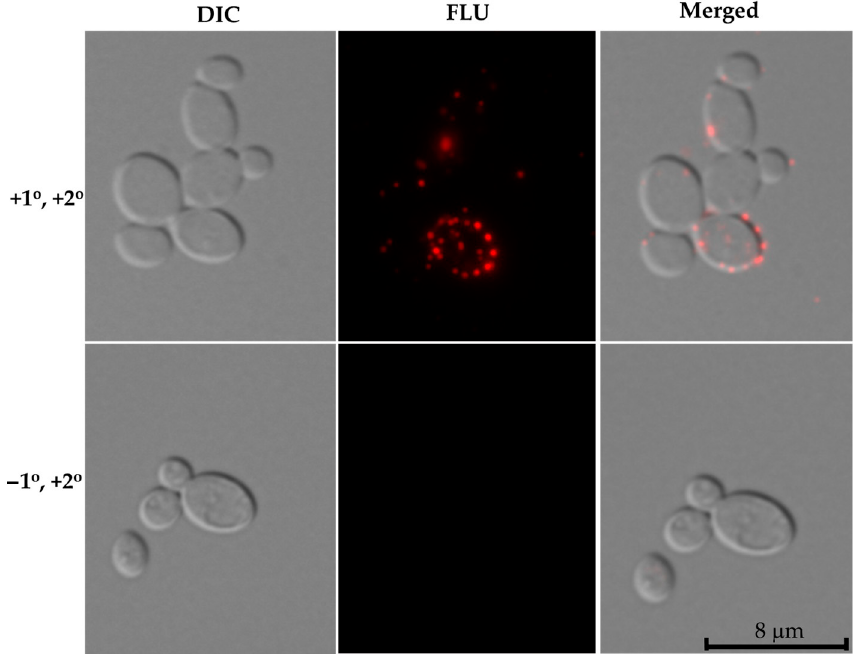
Figure 5. Immunofluorescence of cell surface expressed Nrg1p in C. auris . Synthetic sweat media grown C. auris cells were stained with anti- Cal Nrg1 antibody followed by anti-rabbit Alexa Fluor- secondary antibody and observed under a fluorescence microscope (upper panel). Cells without primary antibody (anti- Cal Nrg1 antibody) and with anti-rabbit Alexa Fluor-secondary antibody are showed in lower panel (control). Scale bar = 8 μ m.